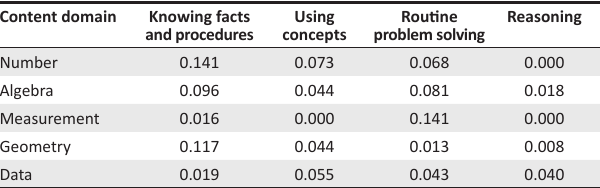
TABLE 8 : Grade 8 RNCS Mathematics content and cognitive domain matrix.